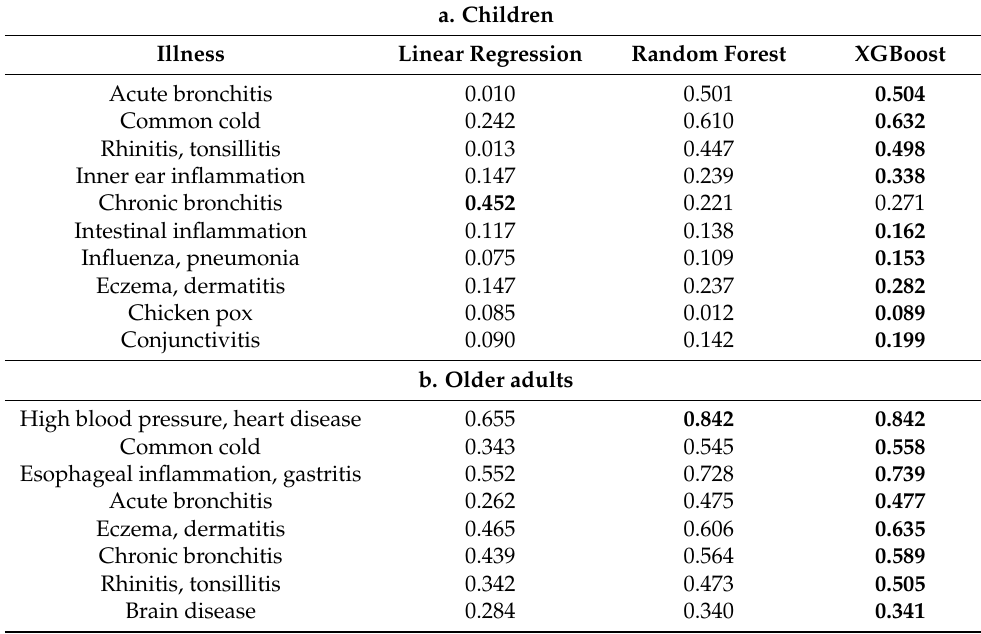
Table 3. Comparison of R 2 value for each machine-learning